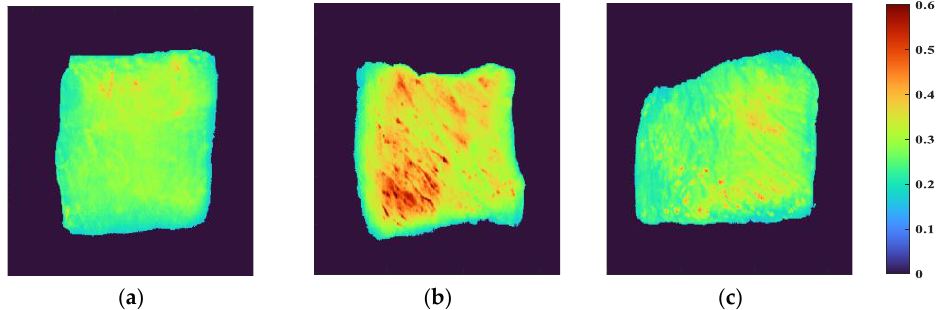
Figure 2. Visualization of spectral reflectance index of beef samples from different parts: ( a ) FD, ( b ) LD, and ( c ) HD.